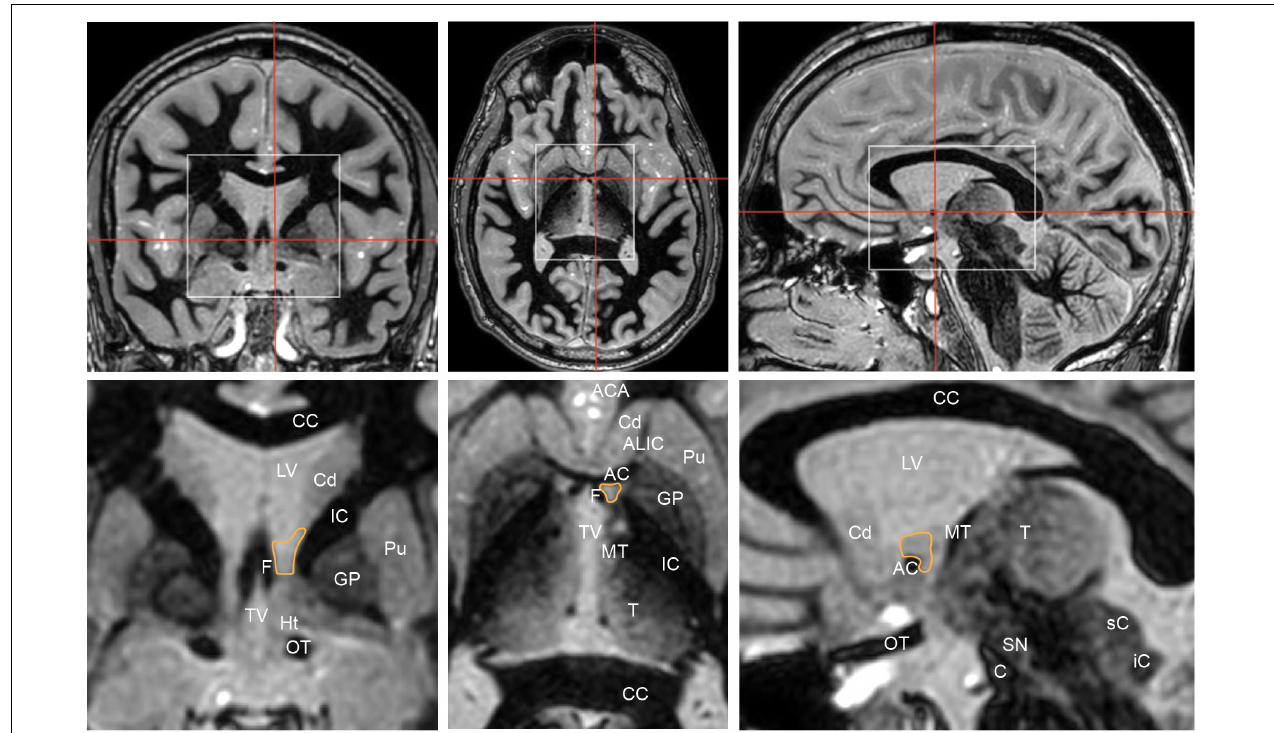
FIGURE 3 | Coronal (left), axial (middle), and sagittal (right) Fast Gray Matter Acquisition T1 Inversion Recovery (FGATIR) sequences highlight the position of the bed nucleus of the stria terminalis (orange outline). Red lines in top row indicate corresponding cuts in other axes. White boxes in top row show regions that are illustrated in greater detail below. Coronal cut is 1 mm posterior to the posterior aspect of the anterior commissure. The bed nucleus of the stria terminalis is bounded laterally by the internal capsule, medially by the fornix. AC, anterior commissure; ACA, anterior cerebral arteries; ALIC, anterior limb of internal capsule; C, crus cerebri; CC, corpus callosum; Cd, head of caudate; F, column of fornix; GP, globus pallidus; Ht, hypothalamus; IC, internal capsule; iC, inferior colliculus; LV, lateral ventricle; MT, mammillothalamic tract; OT, optic tract; Pu, putamen; sC, superior colliculus; SN, substantia nigra; T, thalamus; TV, third